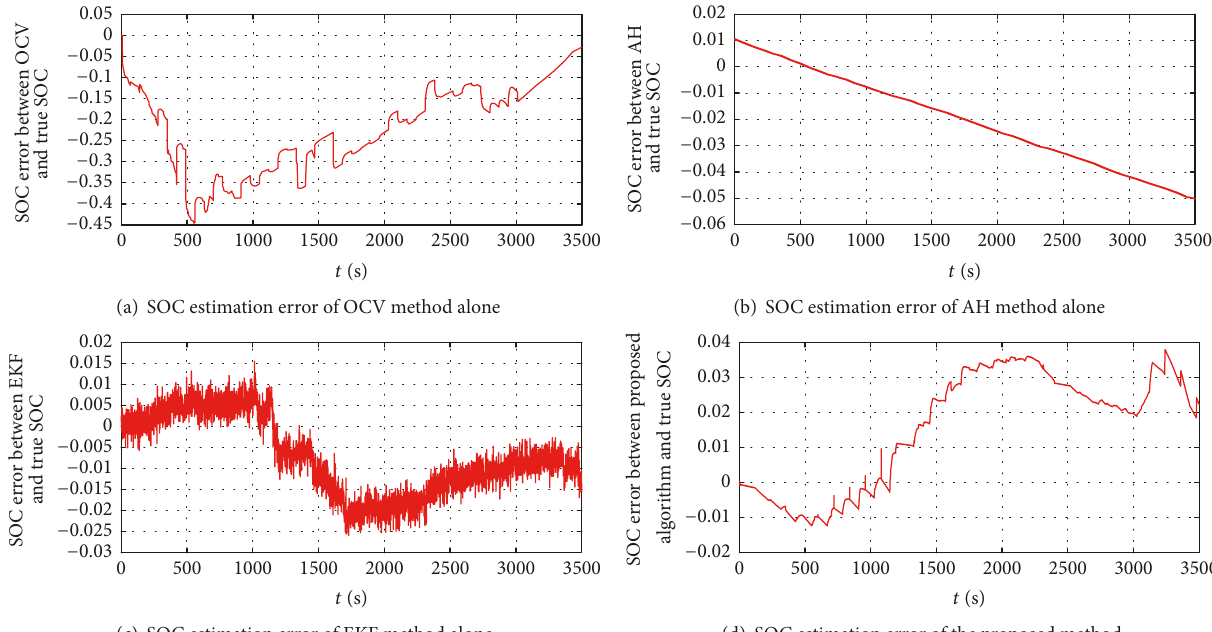
(d) SOC estimation error of the proposed method Figure 14: SOC estimation error.